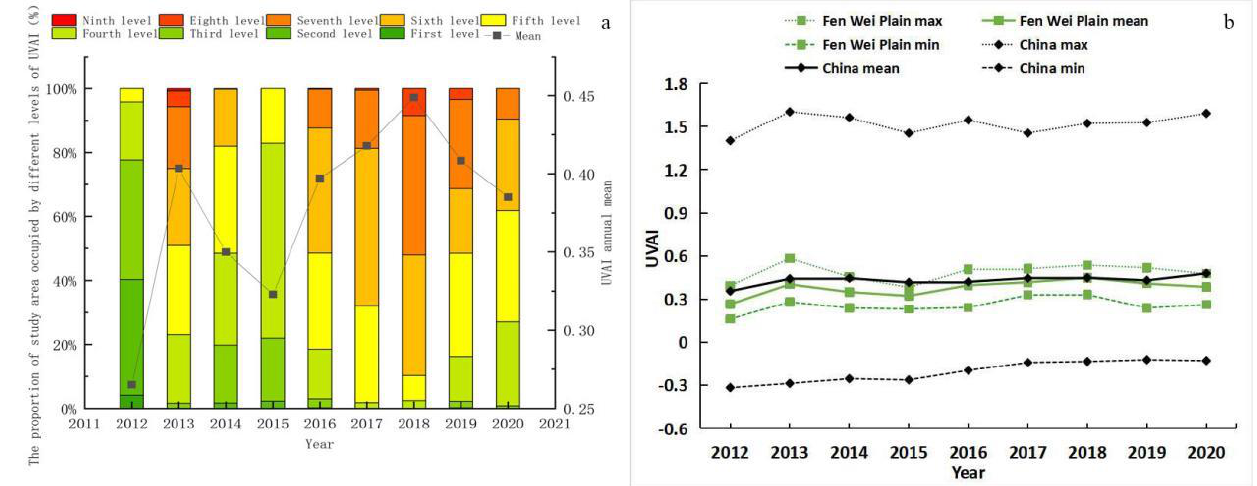
Figure 4. Temporal changes of UVAI values in the Fenwei Plain from 2012 to 2020: ( a ) the proportion of different grades of the annual average UVAI value and the change of the annual average value and ( b ) the comparison chart of the UVAI value change between the Fenwei Plain and China.